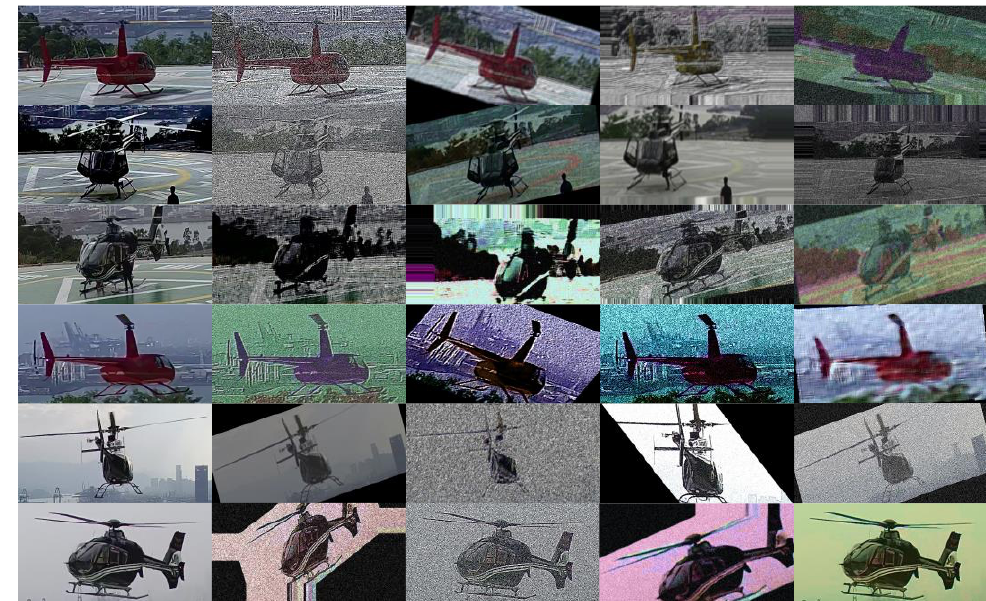
Figure 7. Selected data sets after data enhancement.